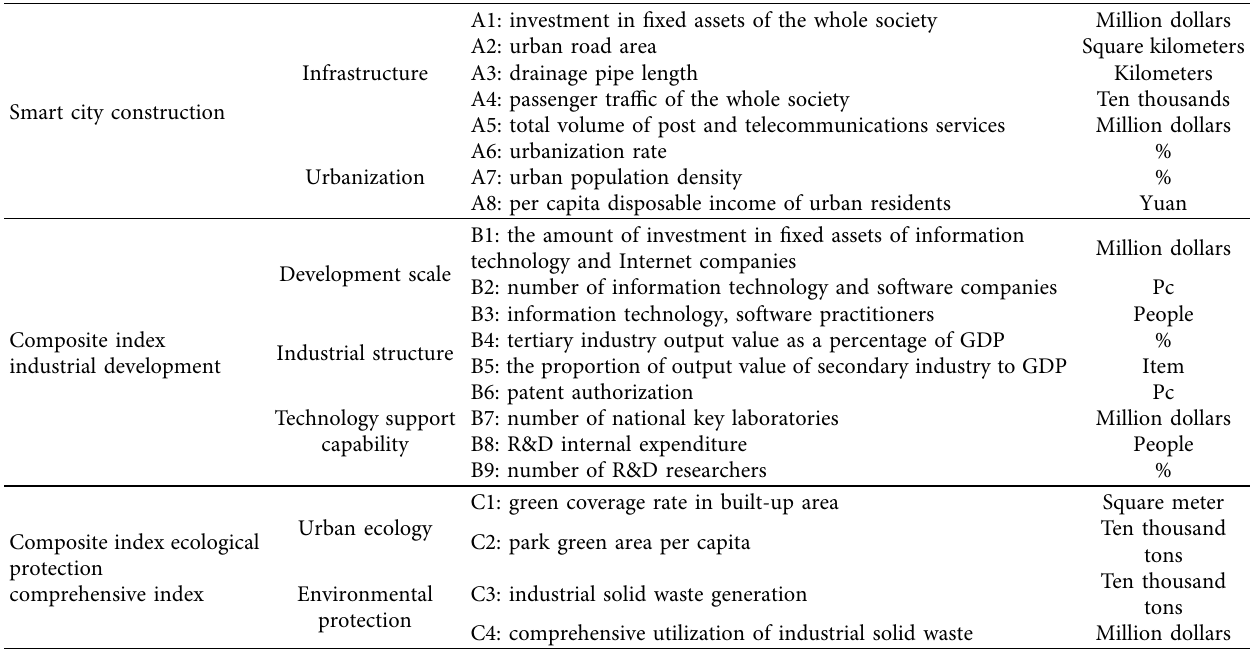
Table 1: Evaluation index system.